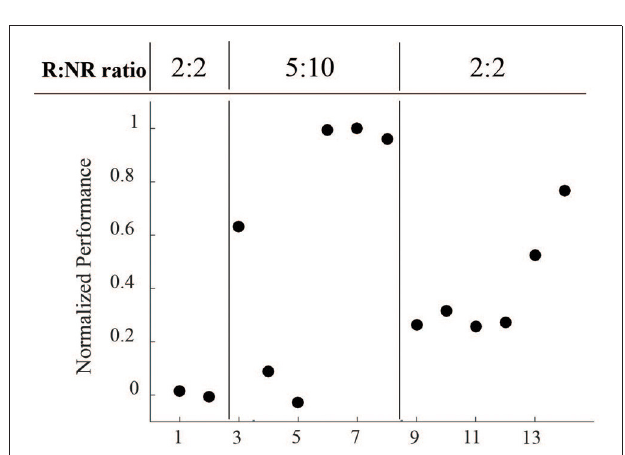
FIGURE 8 | Normalized performance across varying reinforced epoch ratios during LFP conditioning. Performance, as measured by R events per minute minus NR events per minute, normalized to the maximum value, was directly affected at each epoch ratio transition, but returned to higher levels over time.